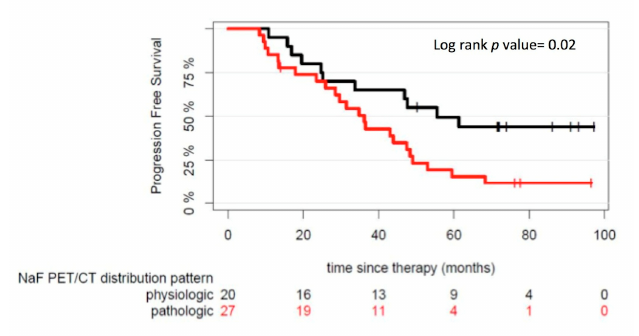
Figure 2. Progression-free survival (PFS) outcome after start of therapy according to physiologic and pathologic 18 F-NaF PET / CT distribution patterns. The numbers of patients at risk in each group and for the respective time-points are shown below the plots.